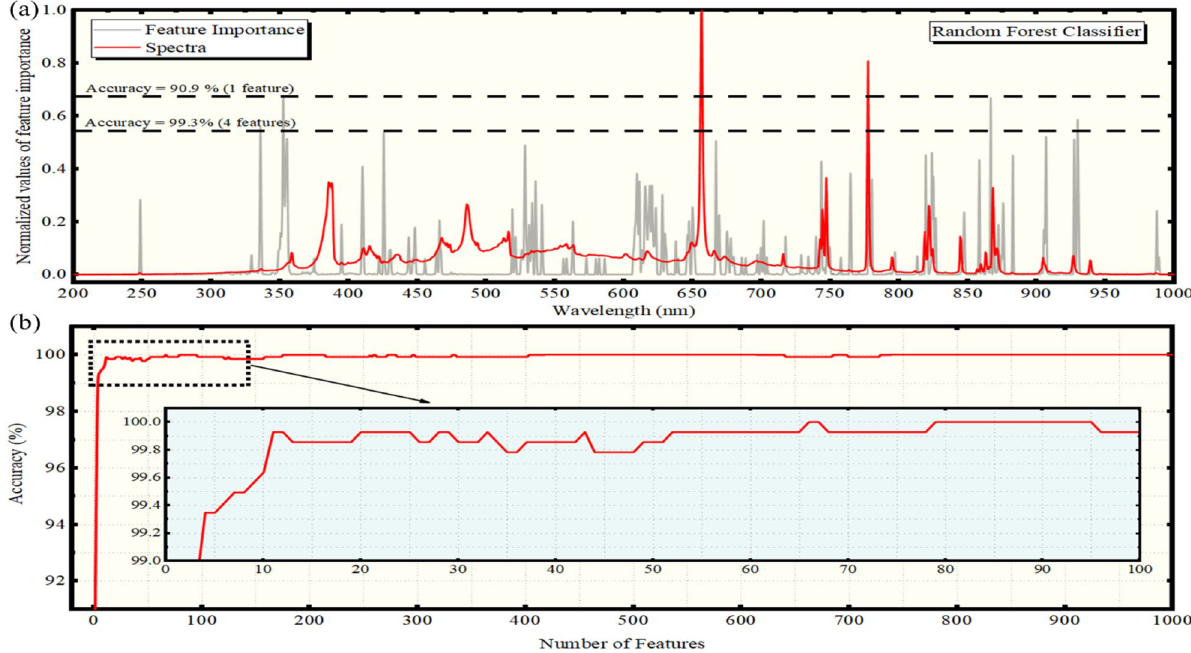
Figure 3. ( a ) Feature importances (gray line) versus wavelength resulting from the RFC algorithm. An experimental LIBS spectrum (red line) is shown for comparison. The horizontal dashed lines indicate the number of features threshold and the corresponding computed accuracies. ( b ) Prediction accuracy using the RFC algorithm versus the number of